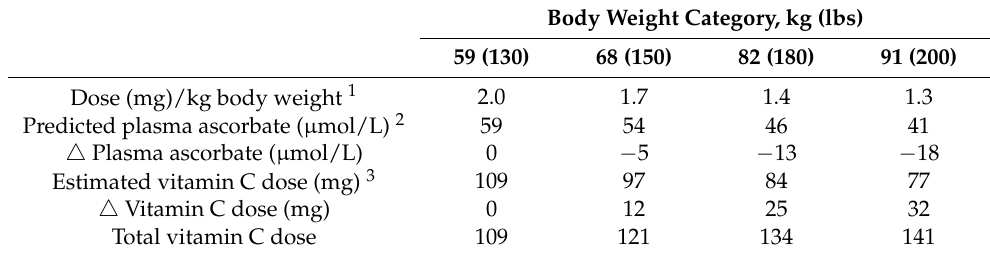
Table 1. Estimated vitamin C doses based on body weight